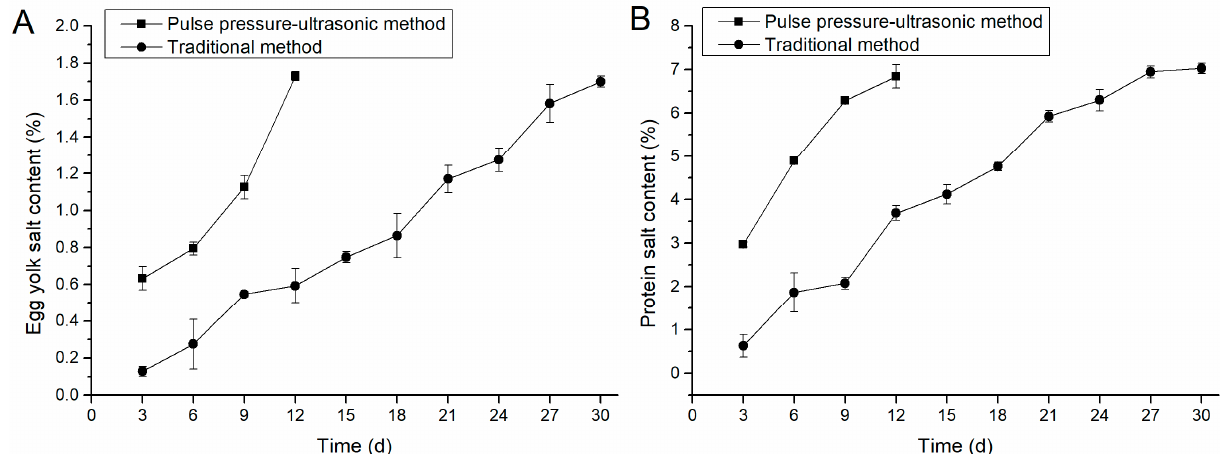
Figure 1. Comparison of salt content in egg yolk and egg white. ( A ) shows the variation of egg yolk salt content with time under di ff erent process conditions. ( B ) illustrates the variation of egg-white salt content with time under di ff erent process conditions.